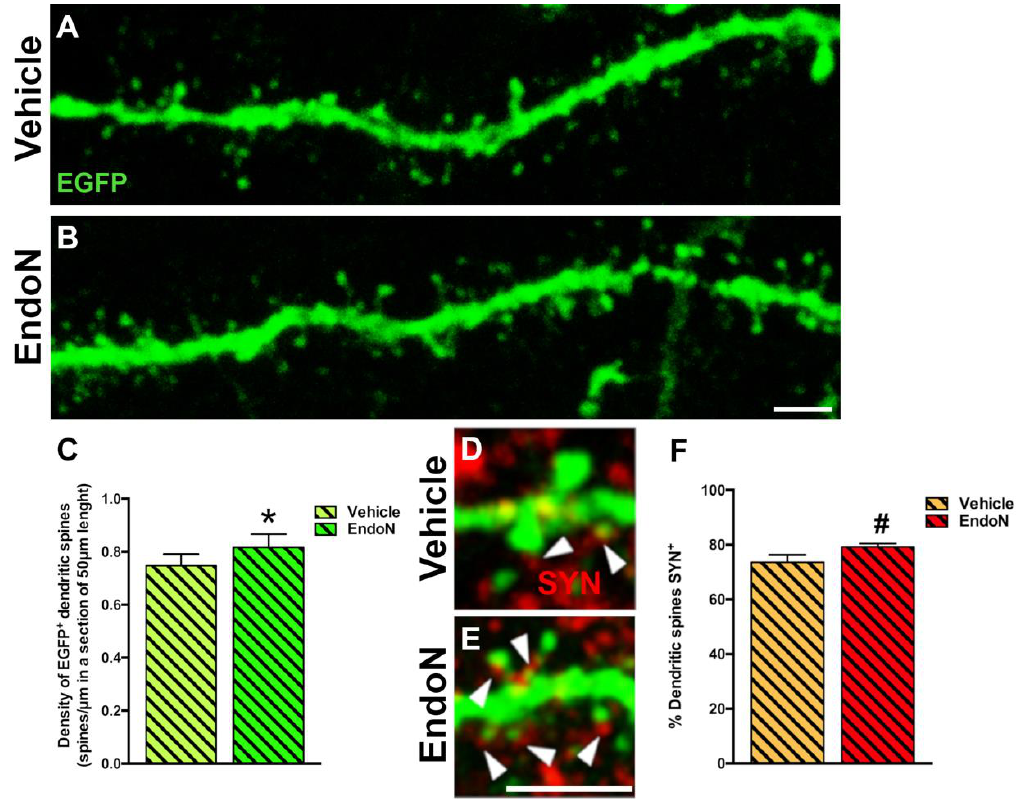
Figure 7. Confocal analysis of the density of dendritic spines in the PCX layer I. ( A , B ) 2D projections of confocal stacks (20 confocal planes separated by 0.38 µm) of spiny dendrites from the vehicle ( A ) and Endo-N ( B ) hemispheres. ( C ) Graph showing increased the density of dendritic spines in a segment of 50 µm in the Endo-N hemisphere. ( D , E ) Higher magnification views of the dendritic spines of complex EGFP + cells in close apposition to puncta expressing the presynaptic markers SYN (red) on their surface. Note the presence of a larger number of puncta expressing SYN (arrowheads) in the Endo-N hemisphere ( E ) when compared to the vehicle hemisphere ( D ). ( F ) Graphs showing the percentage of puncta expressing SYN apposed to EGFP + spines. Asterisks indicate statistically significant differences between hemispheres (Vehicle vs. Endo-N) after paired Student’s t -test. (* p ≤ 0.05; 0.05 < # p < 0.1). Scale bar: 5 µ m ( B ) and 15 µ m ( E